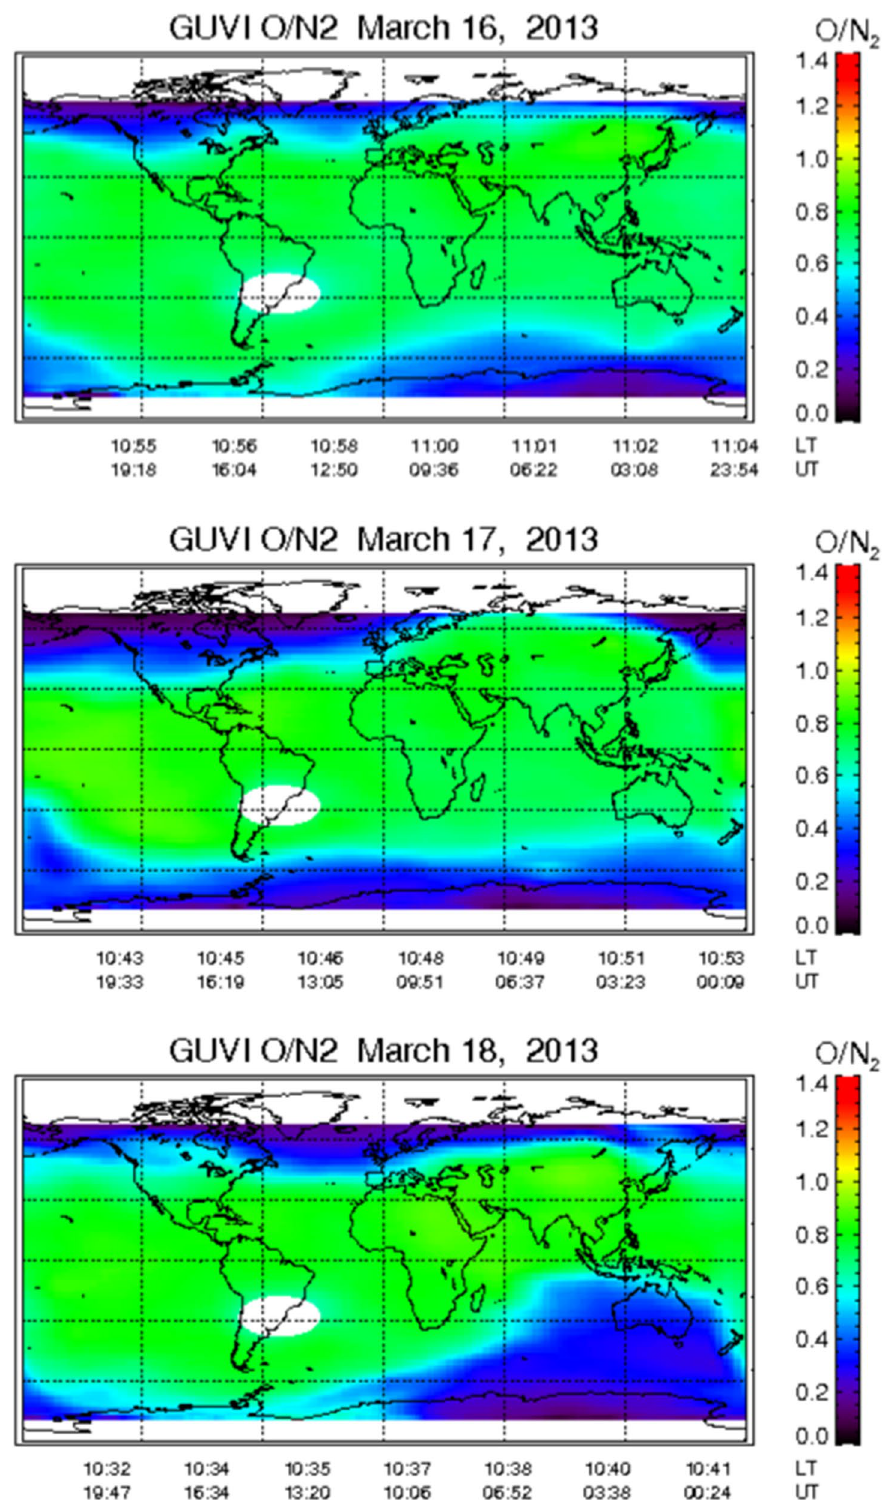
Fig. 7 Global map of thermospheric [O]/[ N 2 ] from the Global Ultraviolet Imager (GUVI) experiment flown on the TIMED satellite for the period between 16 and 18 March 2013. Data gaps are represented by the white spaces in each